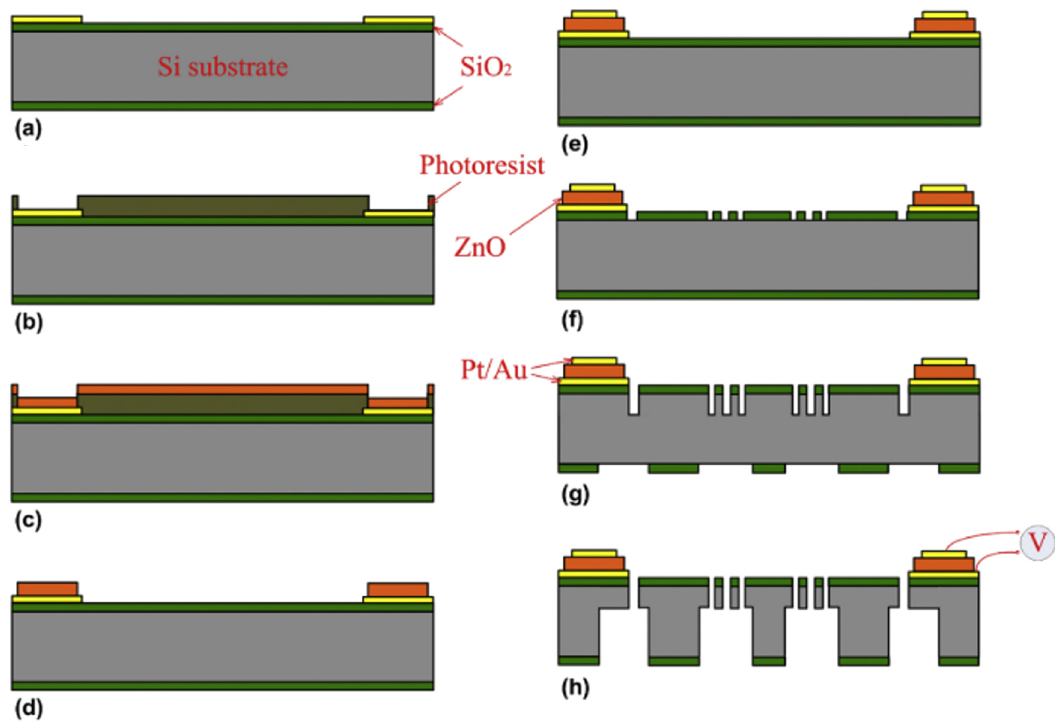
Figure 9: Procedure for the development of the 2DOF MEMs based on the ZnO. Reproduced with permission from Elsevier [ 176 ] . ( a ) Patterning Pt/Au bottom electrode through a lift - o ff process, ( b ) spin - coating photoresist and followed by lithography, ( c ) deposition of ZnO by sputtering at room temperature, ( d ) remove photoresist by wet etching, ( e ) deposition of Pt/Au top electrode, ( f ) patterning SiO2 by RIE, ( g ) frontside feature patterning through lithography and DRIE process, and ( h ) backside feature patterning and realease the